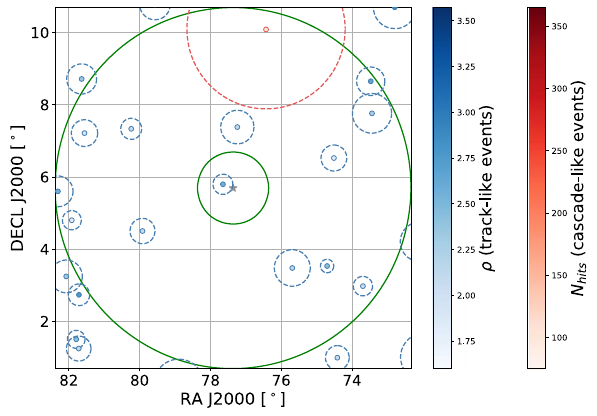
Figure 2. Selected ANTARES events from 2007–2017 around TXS 0506 + 056 (gray star) [10] with one and fi ve degree radius green circles. Showers (red) and tracks (blue) shown dashed cir- cles around them indicating the estimated angular error. Point color shades correspond to the energy estimators (legend on